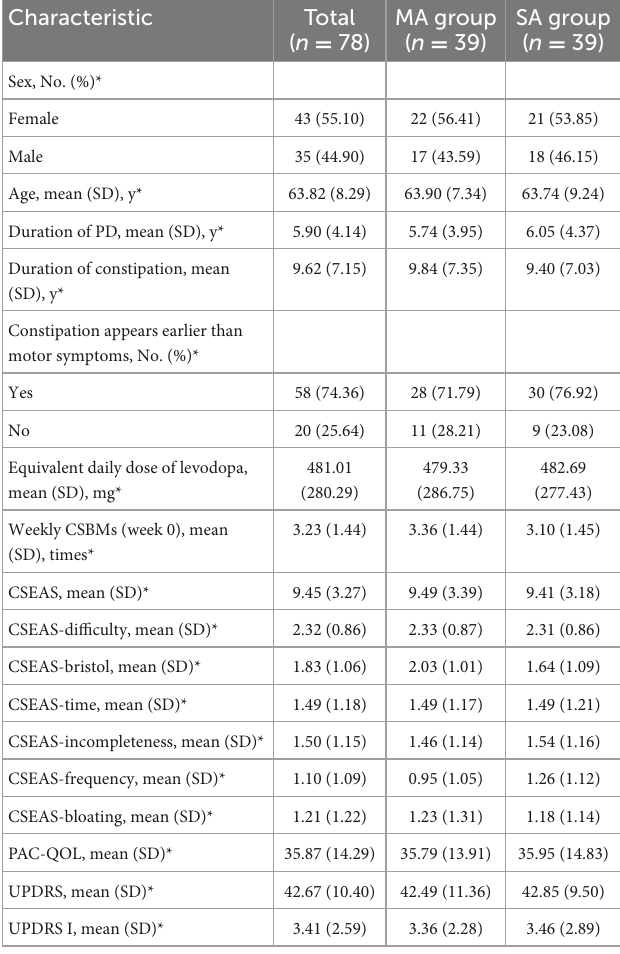
TABLE 1 Baseline characteristics of included patients. Characteristic